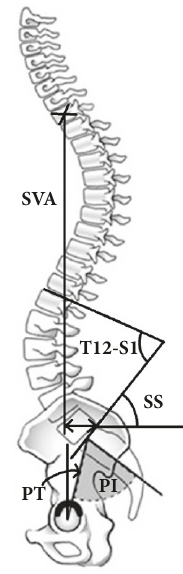
Figure 1: The radiological parameters PI, SS, PT, LL (T 12 -S 1 ), SVA, and